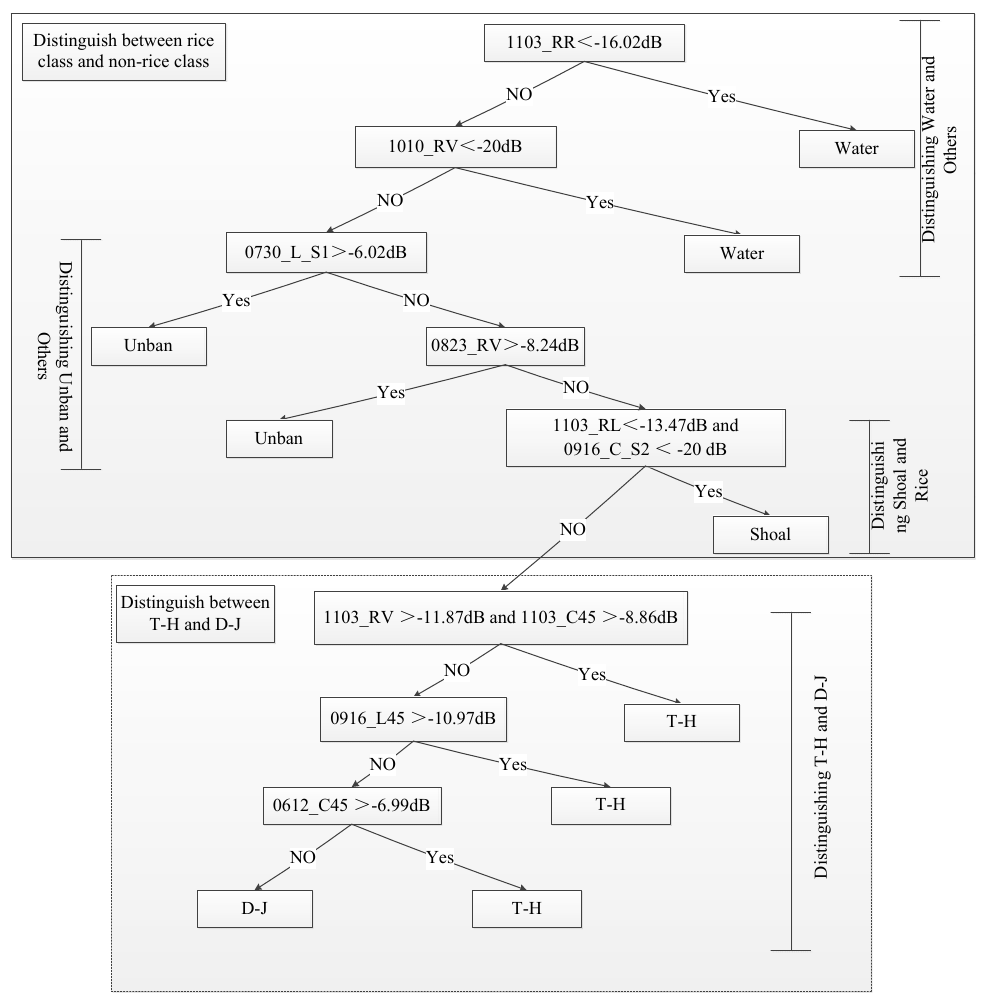
Figure 12. Decision tree classification model.